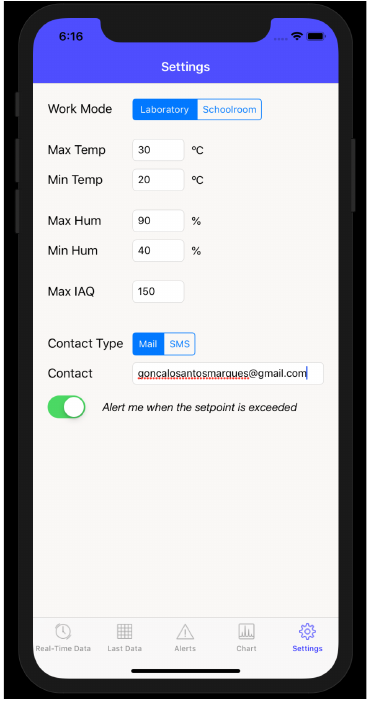
1 Figure 5. iAQ+Mobile